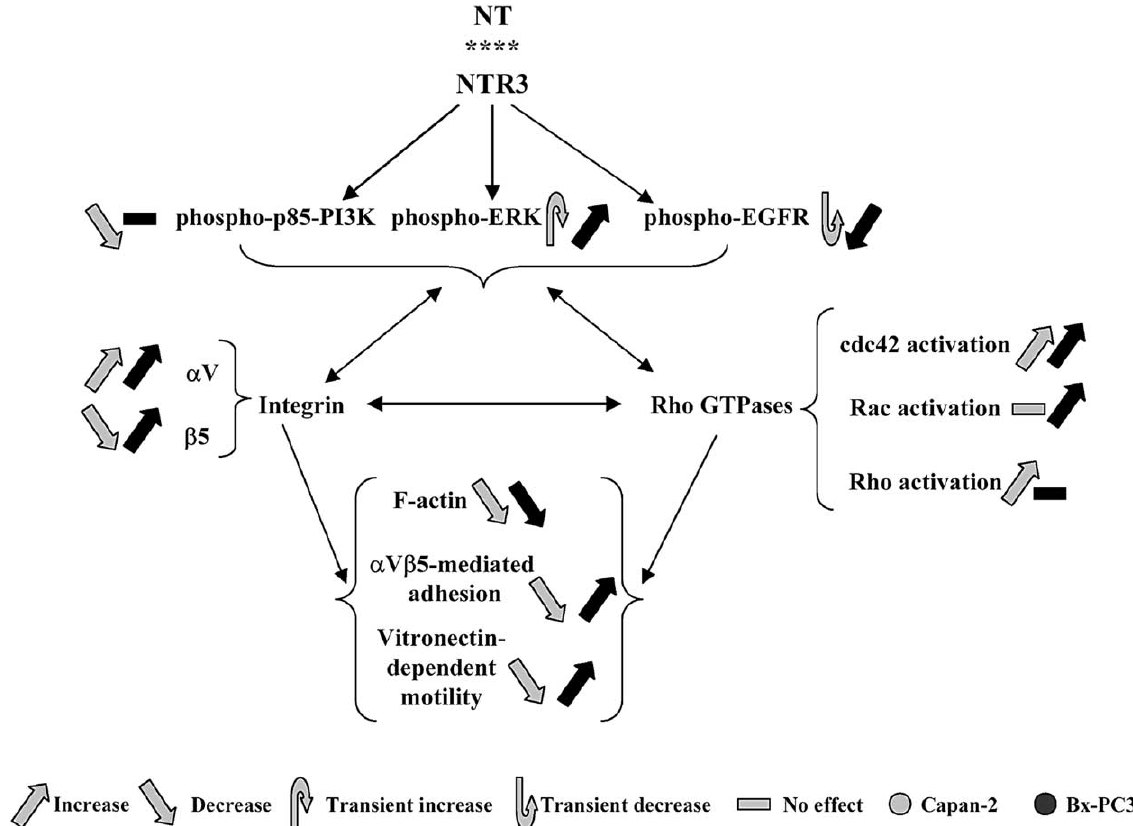
Fig. 4. Hypothetical model explaining the NT-induced effects on PDAC cell migration suggested by our experimental